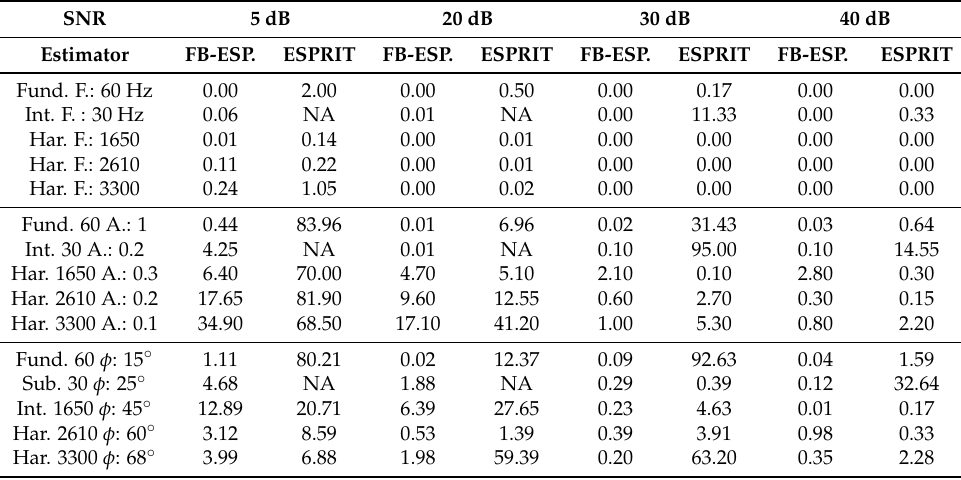
Table 6. Percent error (%) of signal s 1 ( t ) parameters estimated in 1000 runs of the FB-ESPRIT method and the conventional ESPRIT method at different SNR levels (5, 20, 30, 40 dB) while the signal is contaminated with violet